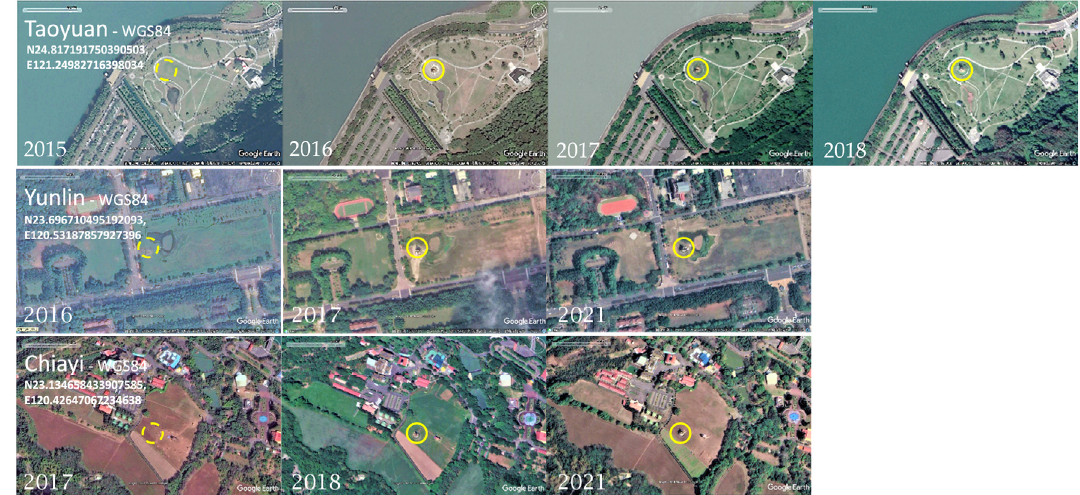
Figure 7. Relocated and reinstalled themed lanterns in satellite images.